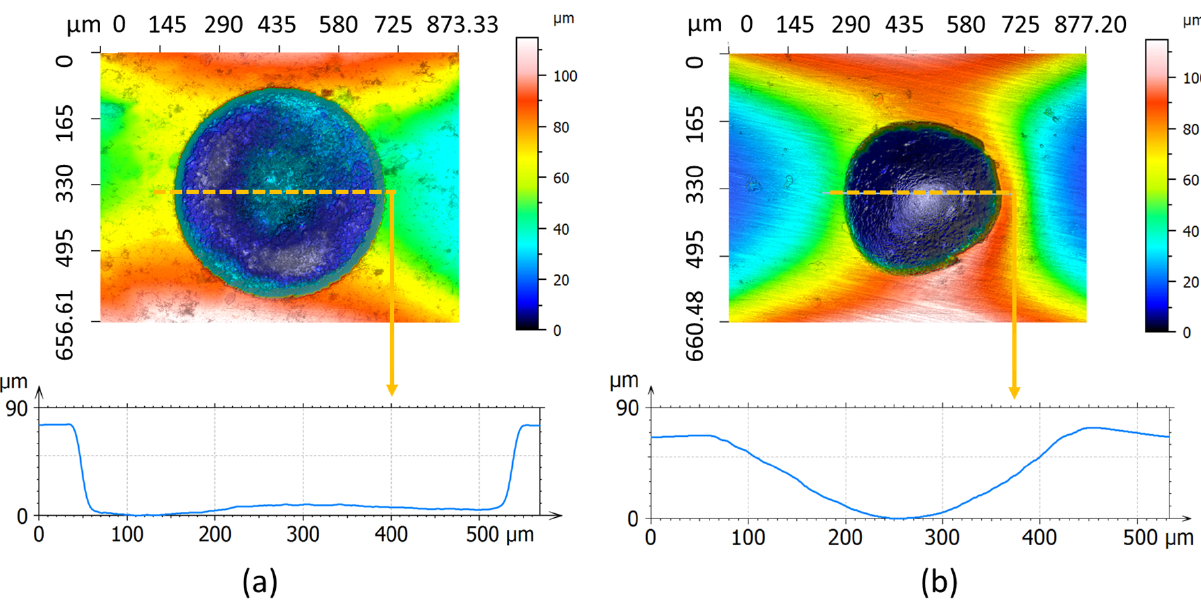
Figure 7. 2D/3D topography and the profile of artificial defects ( a ) pitting produced by micro-EDM ( b ) indentation produced by Vickers hardness machine. Measurement by Sensofar S Neox, with an objective of 20×, form removal and restoration applied and no filtration applied.